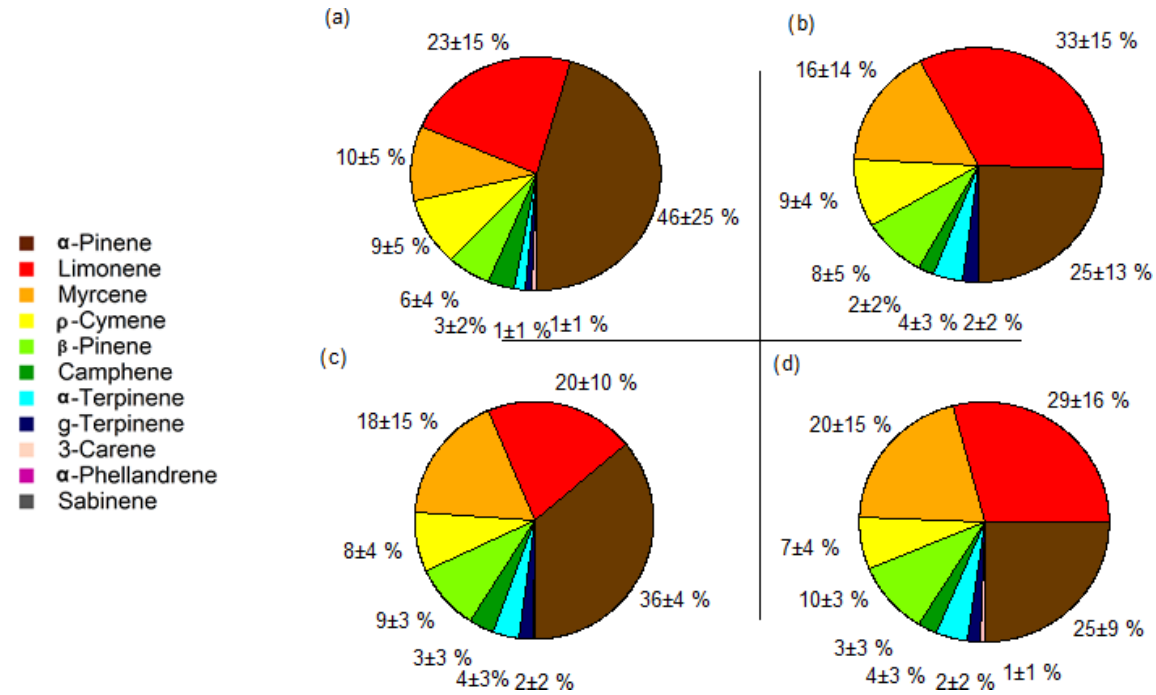
Figure 3. Pie charts representing the daytime (a, c) and night-time (b, d) average monoterpene species’ abundances from 17 to 20 October 2015, with the average percentages and standard deviations at 24 (a, b) and 12m (c, d) . The day period was from 09:00 to 17:00 and the night period was from 20:00 to